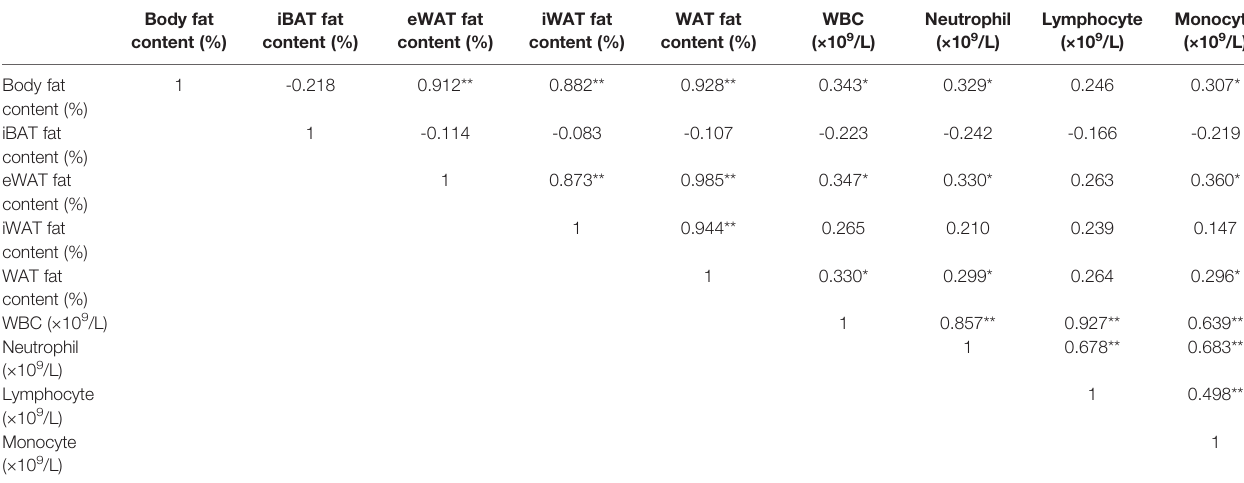
TABLE 2 | Pearson correlation analysis between fat content and blood leukocyte parameters.